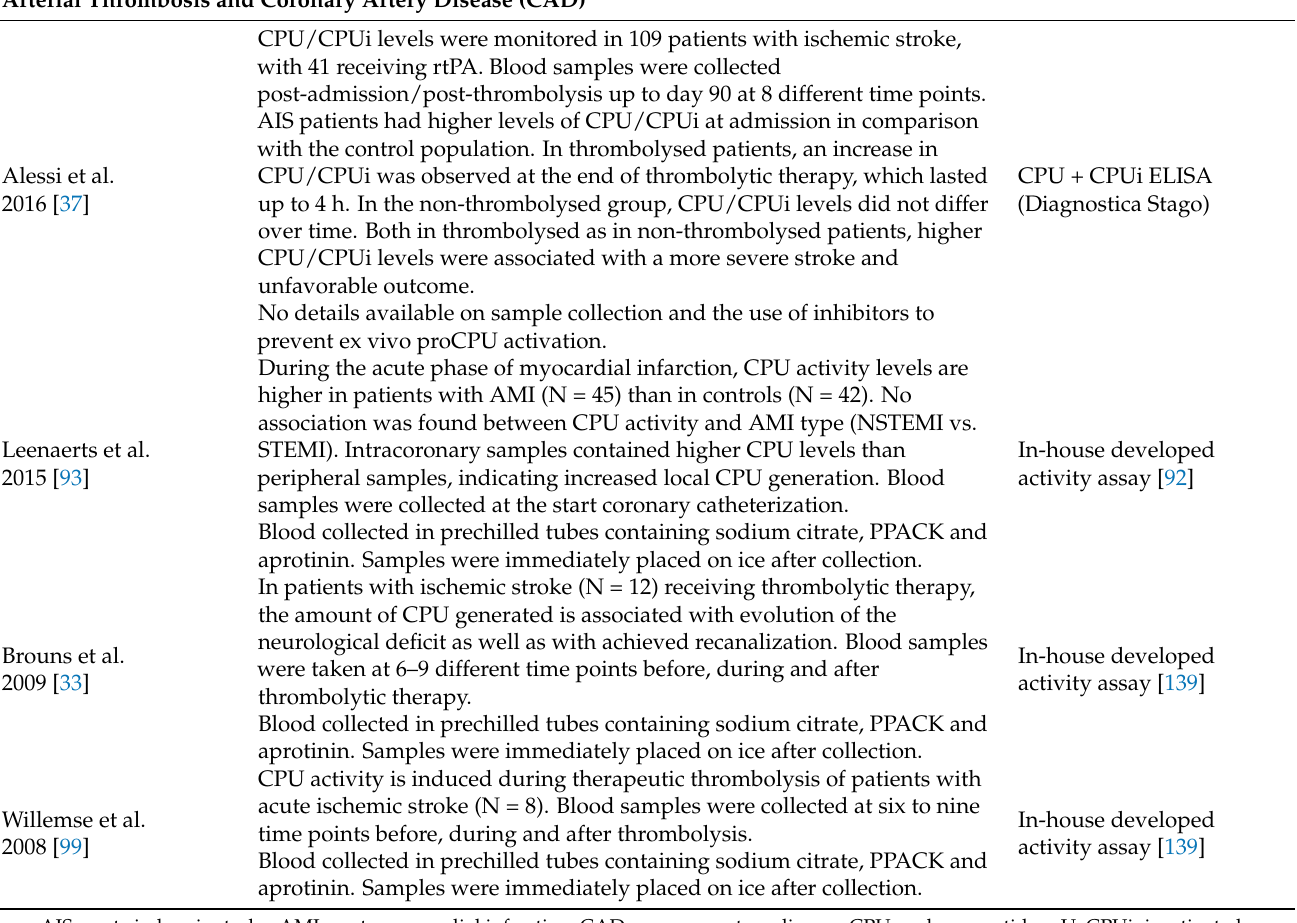
Table 3. Studies investigating the role of CPU and/or CPUi as diagnostic or prognostic biomarkers for thromboembolic diseases during the acute phase. Arterial Thrombosis and Coronary Artery Disease (CAD)